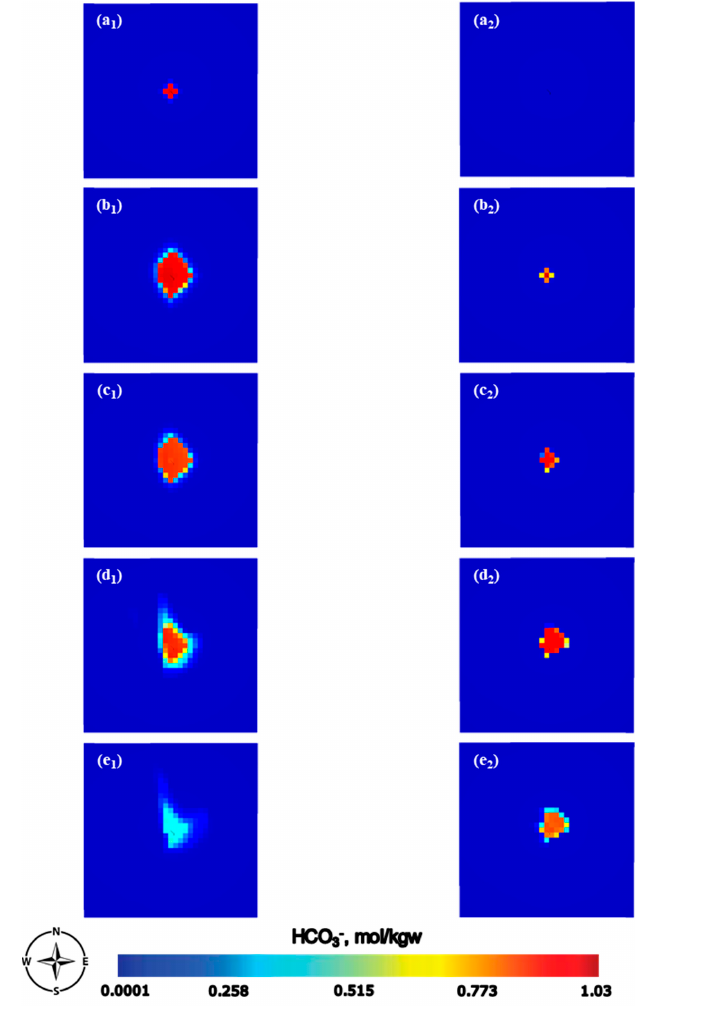
Figure 6. Plan-view diagrams illustrating the simulated HCO 3 − concentration (mol/kgw) evolution for the base case from the arkosic layer top view ( a 1 , b 1 , c 1 , d 1 , e 1 ) and homogenous case from the Upper Mt. Simon top view ( a 2 , b 2 , c 2 , d 2 , e 2 ) at ( a ) 1 year, ( b ) 30 years, ( c ) 100 years, ( d ) 1000 years, and ( e ) 10,000 years. Each figure’s size is 35 km × 35 km (x, y).